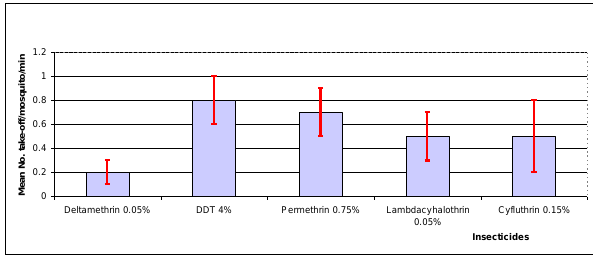
Figure 5: Susceptibility status of An. sacharovi to different insecticides in East Azarbijan Province, Northwest of Iran, 2010